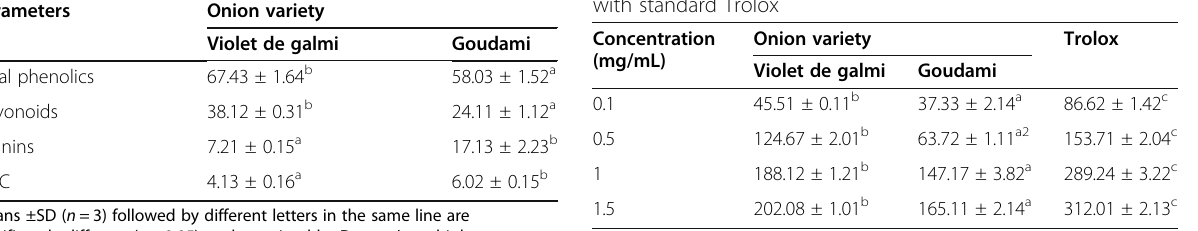
Table 4 DPPH radical scavenging of aqueous extracts of onions with standard Trolox